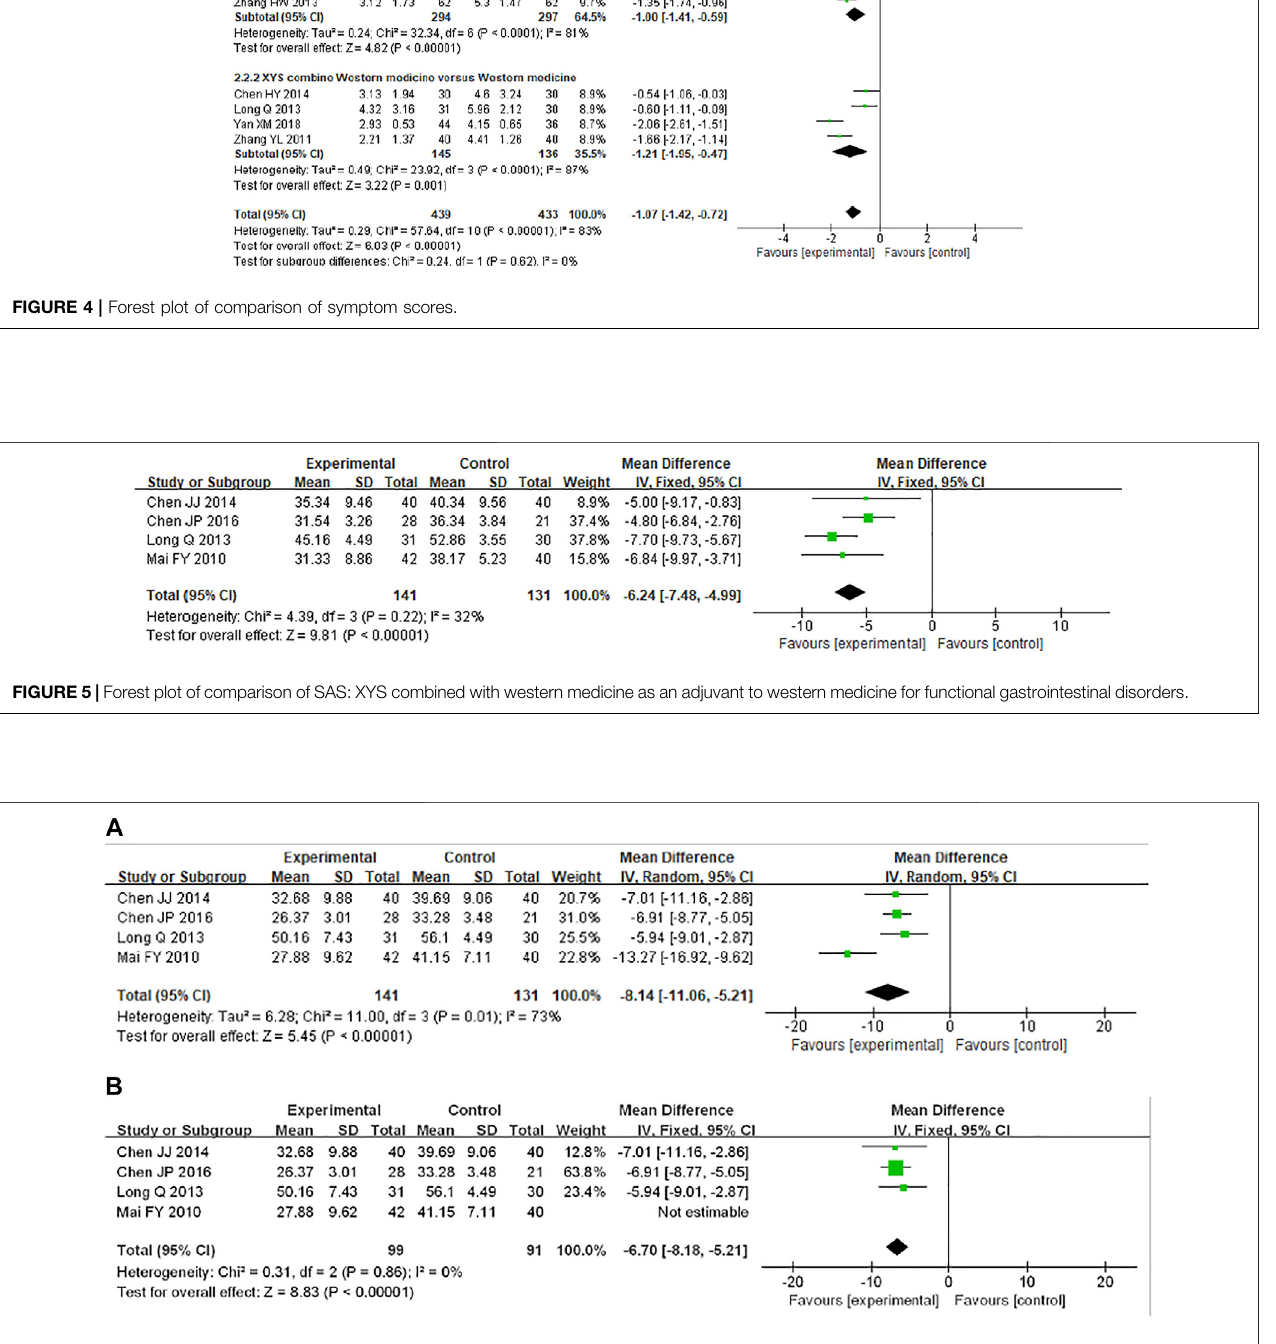
FIGURE 6 | Forest plot of comparison of SDS: XYS combined with western medicine as an adjuvant to western medicine for functional gastrointestinal disorders. (A) Theheterogeneityofthecombinedanalysiswashigh,sotherandomeffectmodelwasused. (B) Sensitivityanalysiswasperformedbysequentialremovalstudies,the main source of